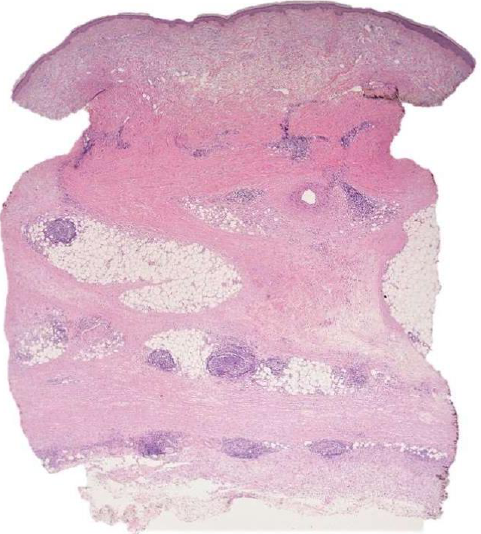
Figure 1. Case 1: Lympho-plasmacellular nodular infiltrate between broad sclerotic bands with Dermatopathology 2022 , 8 , Figure 1. Case 1 : Lympho-plasmacellular nodular infiltrate between broad sclerotic bands with transverse orientation replacing dermo-hypodermal tissue. transverse orientation replacing dermo-hypodermal tissue.